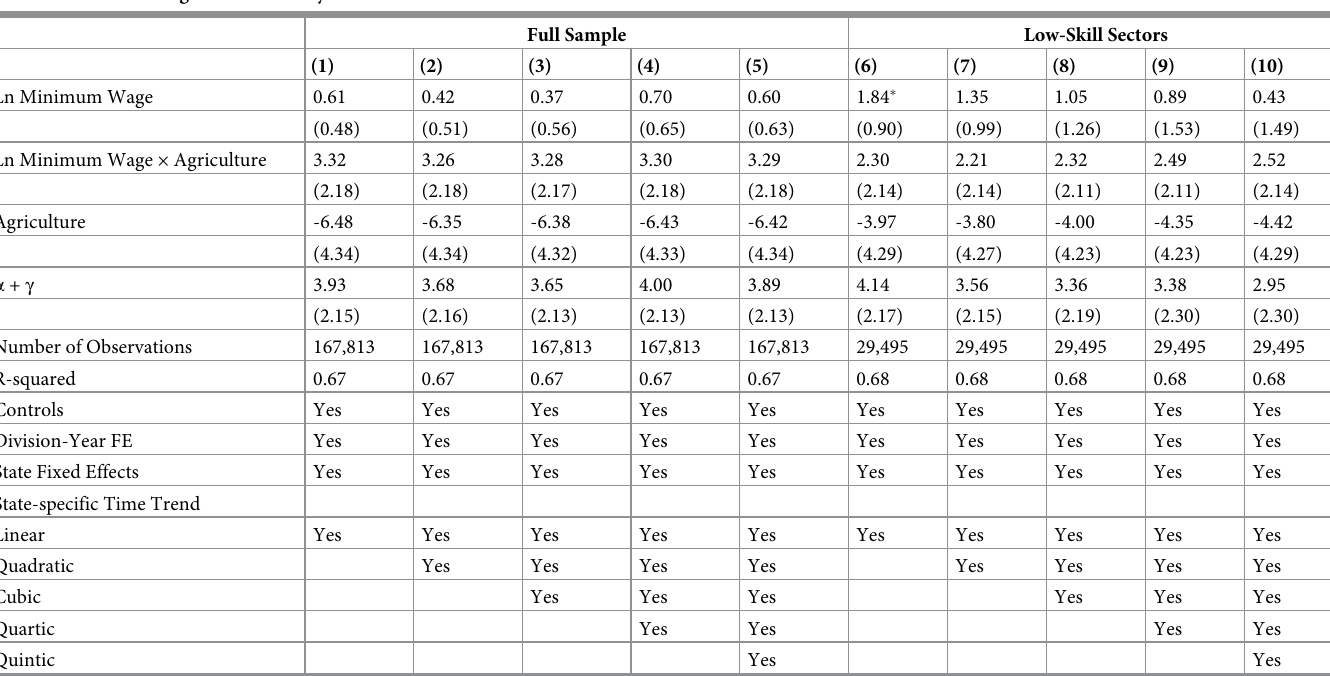
Table 3. Minimum wage law and weekly